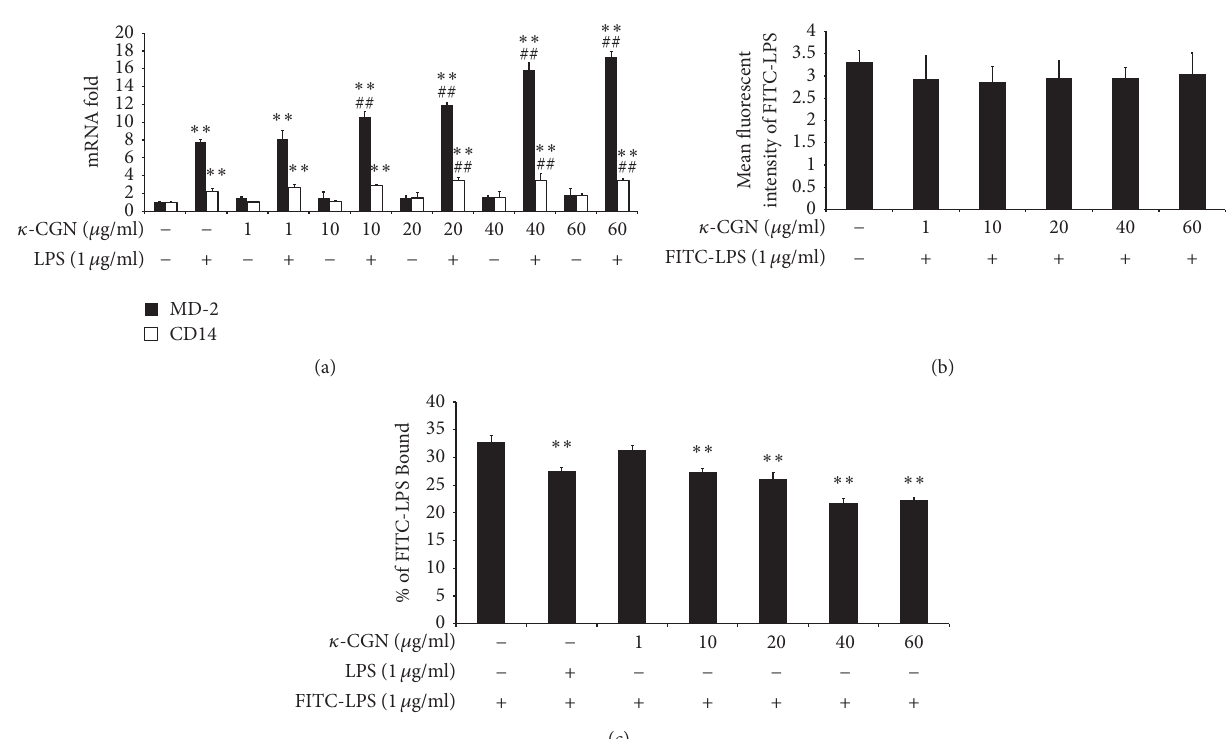
Figure 3: The impact of 𝜅 -carrageenan on mRNA expression of CD14 and MD-2 in LPS-induced HT-29 cells and binding of LPS. (a) The enhanced effect of 𝜅 -carrageenan on mRNA expression of CD14 and MD-2 in LPS-induced HT-29 cells. HT-29 cells were cultured with 𝜅 - carrageenanfor24 horwerepretreatedwith 𝜅 -carrageenanfor1 handthenstimulatedwithLPS(1 𝜇 g/mL)for24h.(b)Effectof 𝜅 -carrageenan on FITC-LPS combined with cells. HT-29 cells were treated with the indicated concentrations of 𝜅 -carrageenan for 24 h and after cells were washed with PBS, and then 1 𝜇 g/mL FITC-LPS was added for 25min. The intensity of fluorescently labeled cells is shown as MFI of FITC-LPS. (c) 𝜅 -Carrageenan competitively blocks the binding of LPS. HT-29 cells were treated with 1 𝜇 g/mL LPS or the indicated concentrations of 𝜅 -carrageenan for 1h, and then 1 𝜇 g/mL FITC-LPS was added for 25 min. ∗∗ 𝑃 < 0.01 , compared with the blank group. ## 𝑃 < 0.01 ( 𝑛 = 3 ), compared with the LPS treated